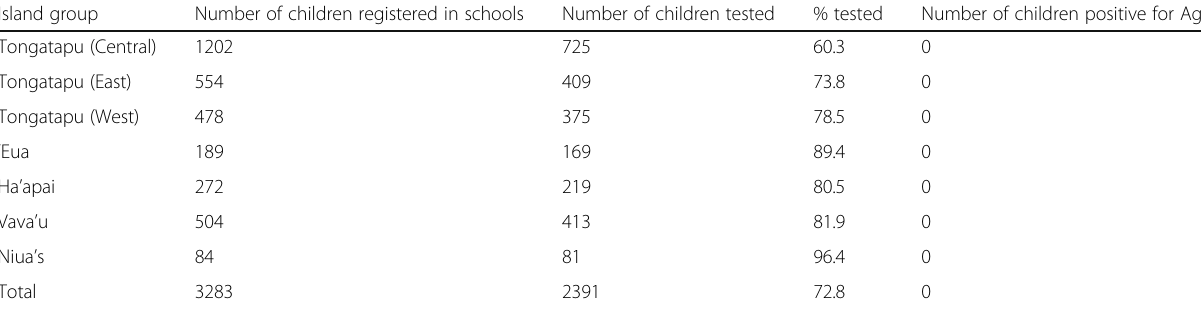
Table 6 Results of D survey conducted in different divisions in Tonga Island